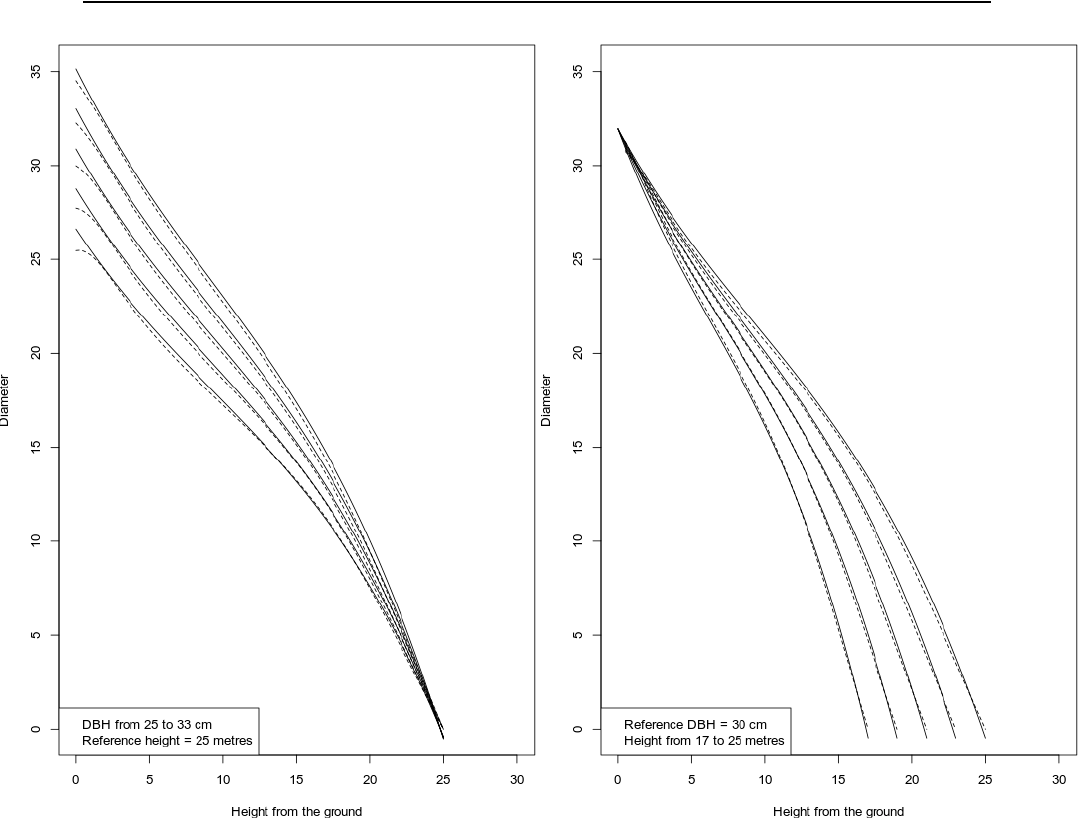
Figure 4. Stem profile generated using the third order polynomial function (continuous line) and TapeR package (dashed line) with two different hypothetical groups of Pinus nigra trees with same height but different DBH (left) and the opposite study case (i.e. same DBH but different height).